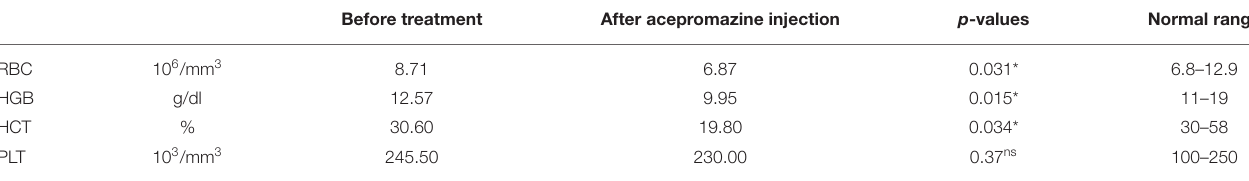
The samples were collected twice: before treatment and 4h after treatment. * significant at p-values < 0.05; ns: non-significant at p-values >